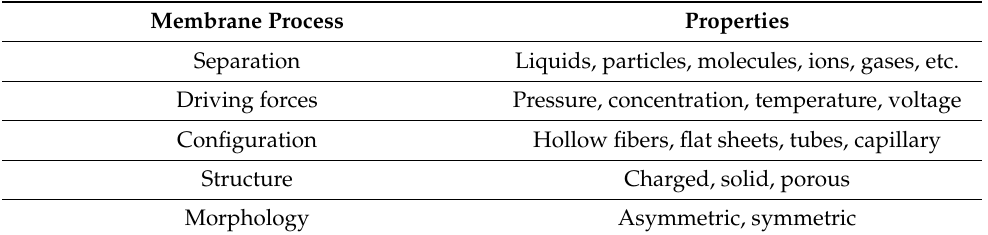
Table 1. Process of membrane technology and properties of